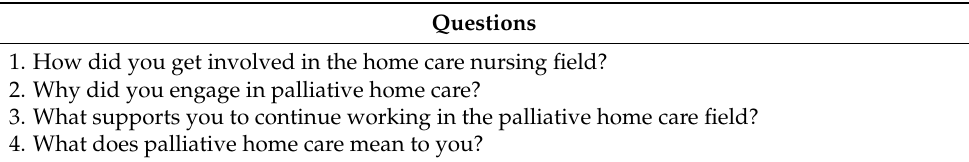
Table 1. Semi-structured interview